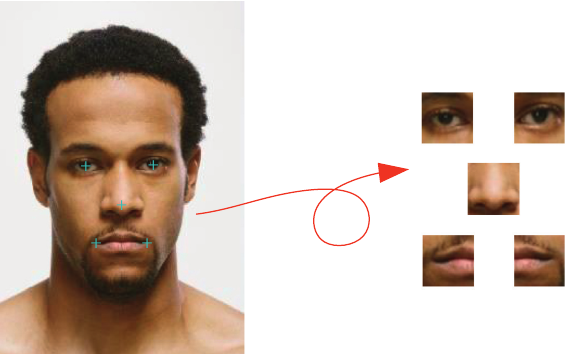
Figure 5: Extraction of face feature points and subfigures of each